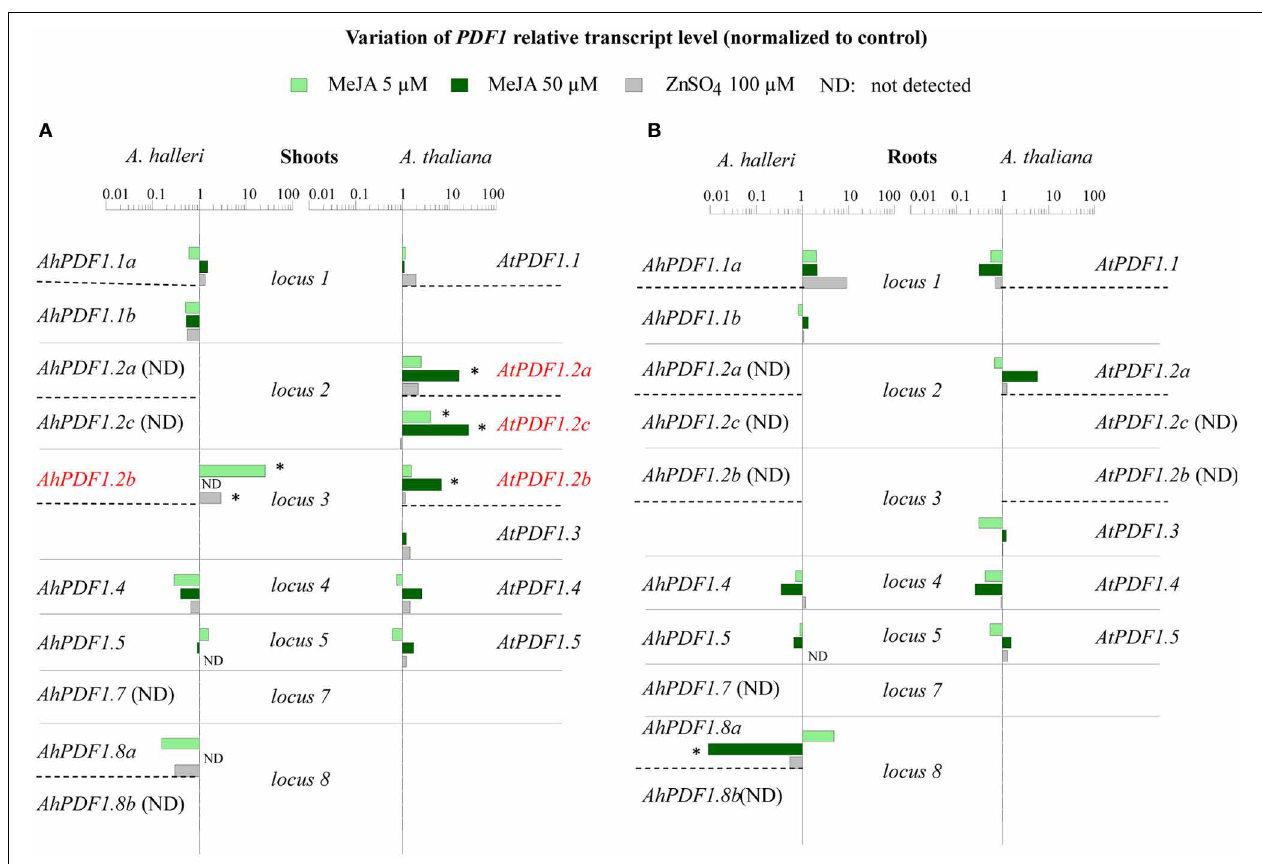
FIGURE 1 | Effect of zinc and MeJA treatments on PDF1 transcript accumulation in shoots and roots within A. thaliana and A. halleri . The ratios of REL as normalized to actin and to control conditions are presented for each PDF1 in shoots (A) and roots (B) . For each organ ( A,B ), the AtPDF1 and AhPDF1 REL ratios are organized according to orthologous loci (separated by plain lines) and the gene-to-gene orthologous relationship (indicated by dashed lines). Shoots and roots were collected separately from individual A. halleri (left panel) and A. thaliana (right panel) plants ( n = 6) that had been transferred to and maintained for 5 days on control media or to